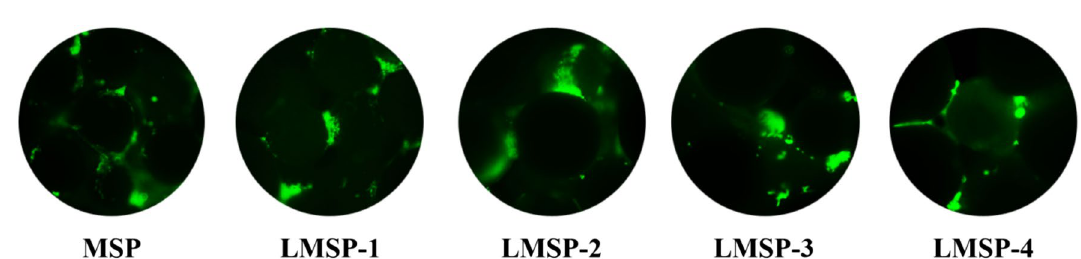
Figure 5. CCK-8 assay for cell proliferation. A: Cells were seeded on MS and LMS-1–4 at concentrations ranging from 50 to 400 ppm for 7 days. (*) Indicates statistical significance when compared with the control group (cells cultured on TCPS without materials) (p < 0.05). B: Cells were seeded on MSP and LMSP-1–4 microsphere-based scaffolds for 3, 7, and 10 days.